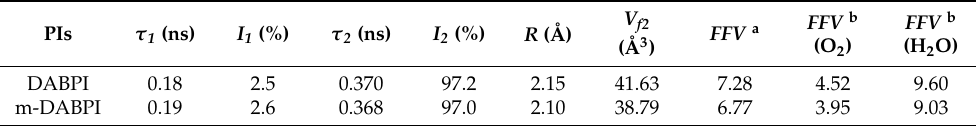
Table 4. Analyzed data of the positron lifetime and simulated FFV values in the DABPI and m- DABPI